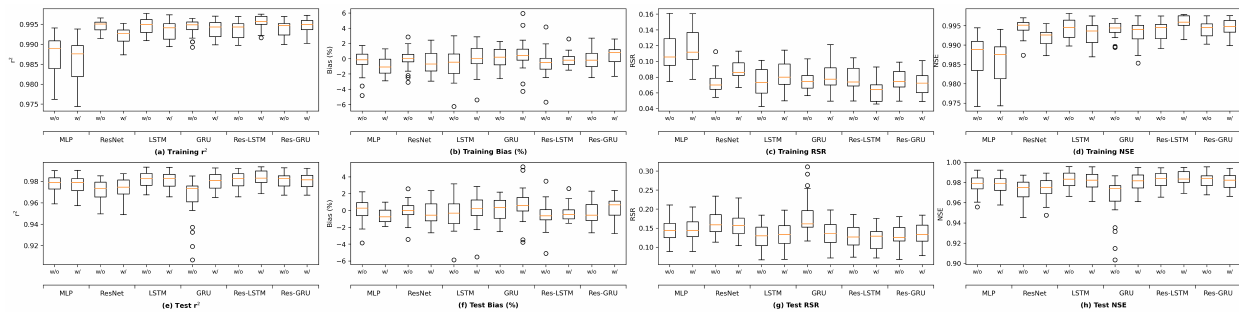
Figure A5. Comparison of six models on observed data without (“w/o”) or with (“w/”) data distortion.